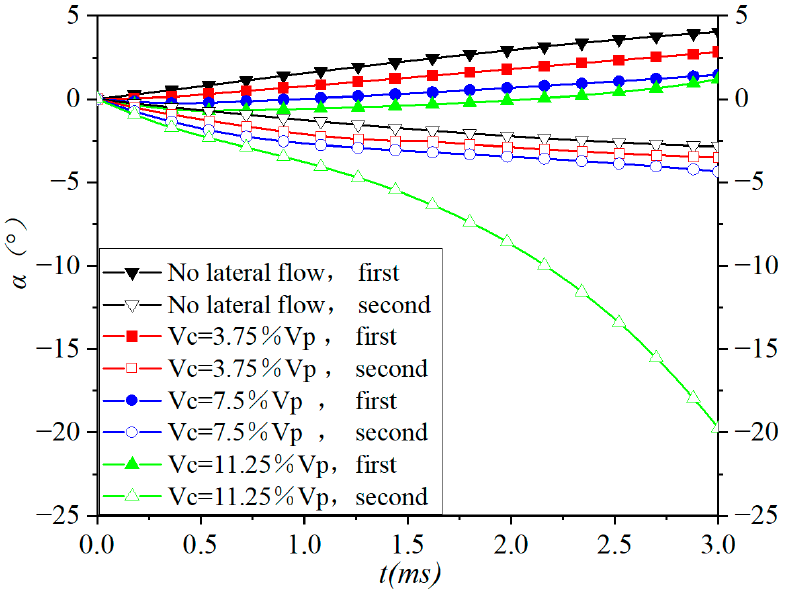
Figure 16. The change in the deflection angle α versus time. Under the condition with lateral flows, the counterclockwise deflection angle of projectile 1 decreases with the increase in the velocity of the lateral flow, while the clockwise deflection angle of projectile 2 increases with the velocity increase in the lateral flow. The deflection angles of projectile 1 and 2 are within 5 ◦ under the condition with no lateral flow and the lateral flow velocity of 3.75% V p and 7.5% V p at t = 3.0 ms. Under the condition of the velocity of the lateral flow at 11.25% V p , the deflection angle of projectile 2 rapidly increases and can reach up to about 20 ◦ at t = 3.0 ms, while that of projectile 1 is only about 1 ◦ . This means the ballistic stability of projectile 1 is much better than that of projectile 2. In addition, the trajectory of projectile 2 significantly deviates from the initial